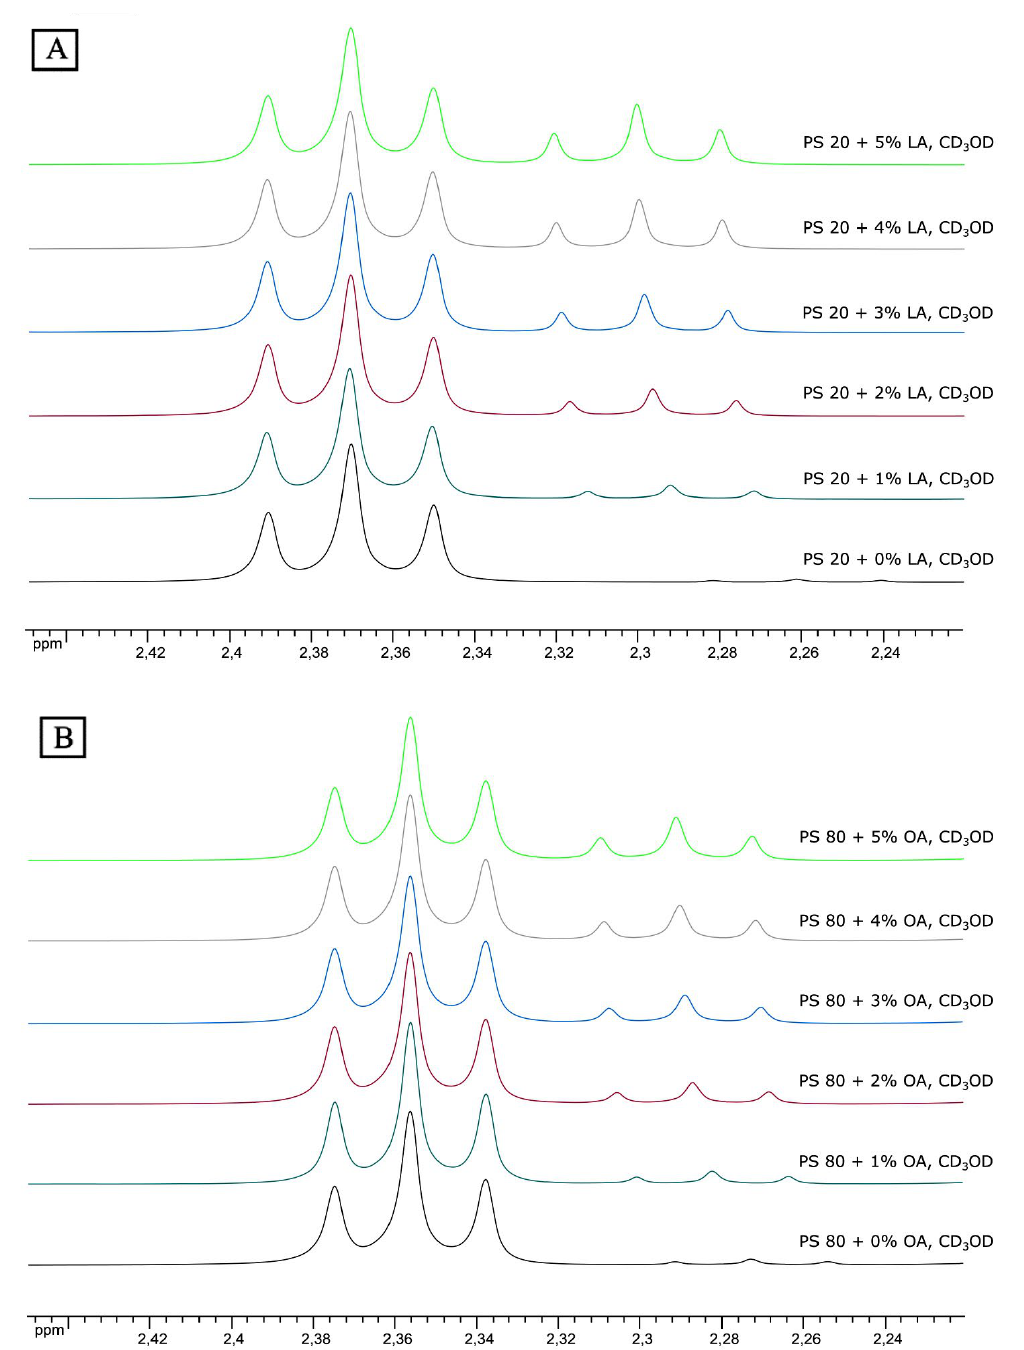
Fig 4. Comparison of spectra for PS 20 (A) and PS 80 (B) in CD 3 OD after spiking with LA or